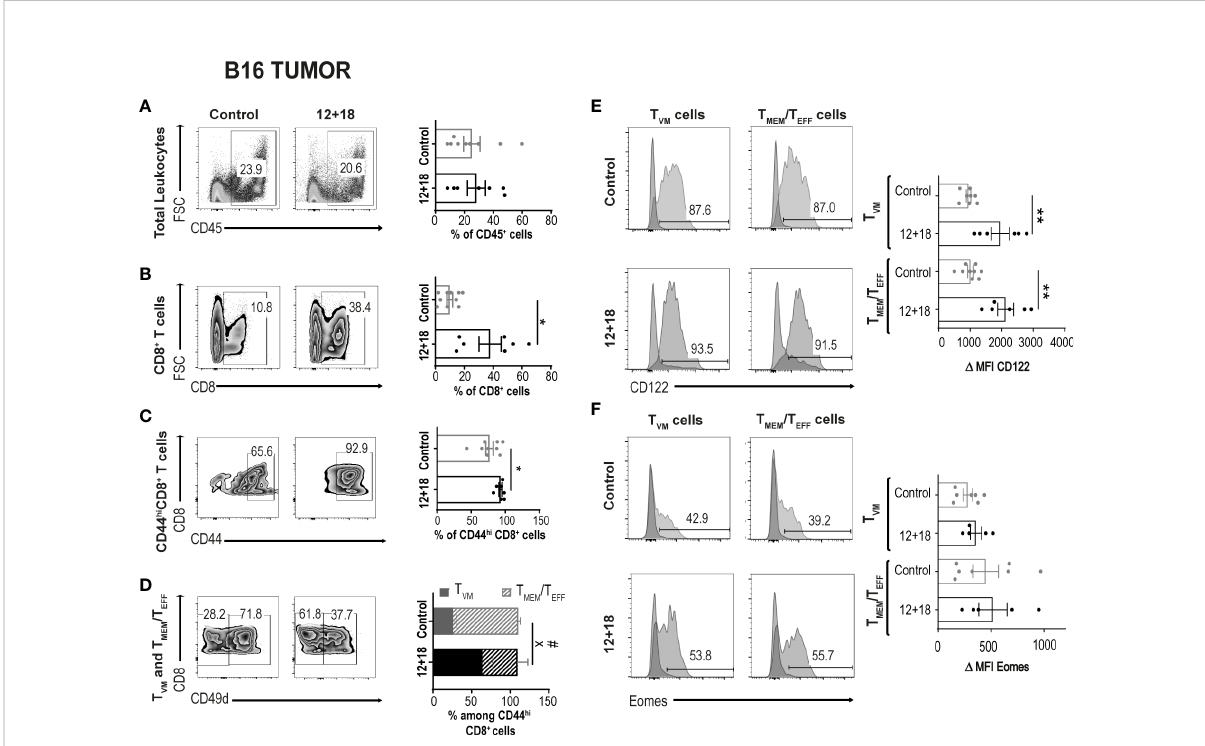
FIGURE 4 Effects of systemic co-expression of IL-12 plus IL-18 on leukocytes and CD8 + T lymphocytes in tumors. B16-bearing C57BL/6 WT mice were hydrodynamically injected (HI) with IL-12 plus IL-18 cDNA (12 + 18) or empty cDNA as the control. After 7 days post-HI mice were euthanized, and tumors were harvested and processed for fl ow cytometry. (A – D) Dot plots and their respective bar graphs represent the frequencies of the speci fi ed subpopulations (total leukocytes, total CD8 + T cells, CD44 hi CD8 + T cells and T MEM /T EFF and T VM cells among CD44 hi CD8 + T cells) from control (left dot plots) or 12 + 18 mice (right dot plots). (E, F) Histograms and their respective bar graphs represent CD122 (top) or Eomes (bottom) frequencies and D MFI on T VM (left histograms) and T MEM /T EFF cells (right histograms) from control (upper histograms) or 12+18 mice (lower histograms). D MFI was calculated as MFI of CD122 or Eomes minus MFI from their respective isotype control. Statistical analysis was performed with Student T test (A) , with Welch correction (B – D) or with a One-Way (E) or Brown Forsythe and Welch (F) ANOVA test as appropriate. Values of *p<0.05, **p<0.01, were consider signi fi cant. # p<0.05 represent the statistical difference of the indicated T MEM /T EFF control vs 12 + 18 subpopulations while X p<0.05 represents the difference among control and 12 + 18 T VM